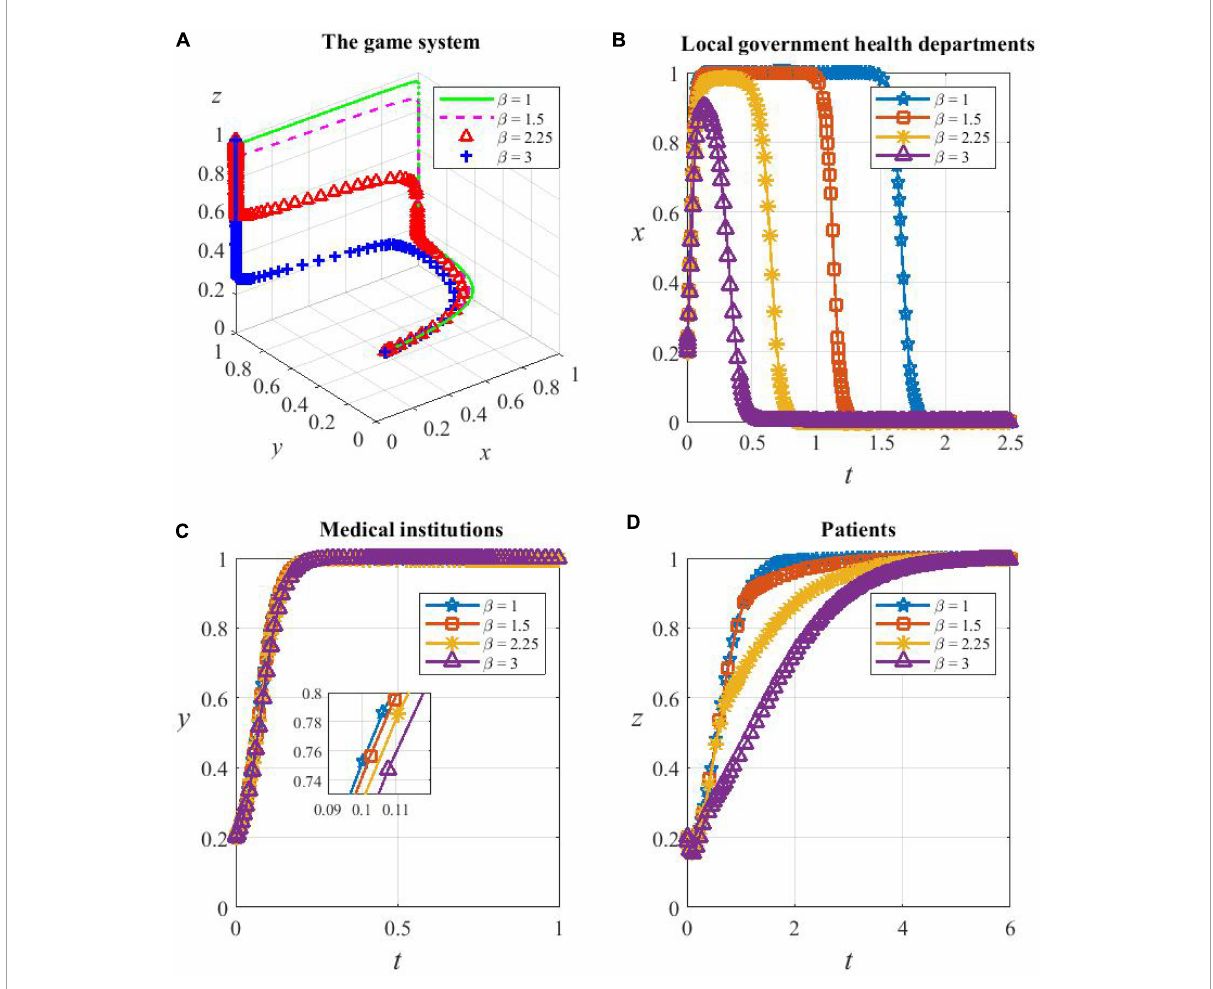
FIGURE10 (A) The game subjects’ sensitivity to β . The whole game system’s sensitivity to β , (B) local government health departments’ sensitivity to β , (C) medical institutions’ sensitivity to β , and (D) patients’ sensitivity to β